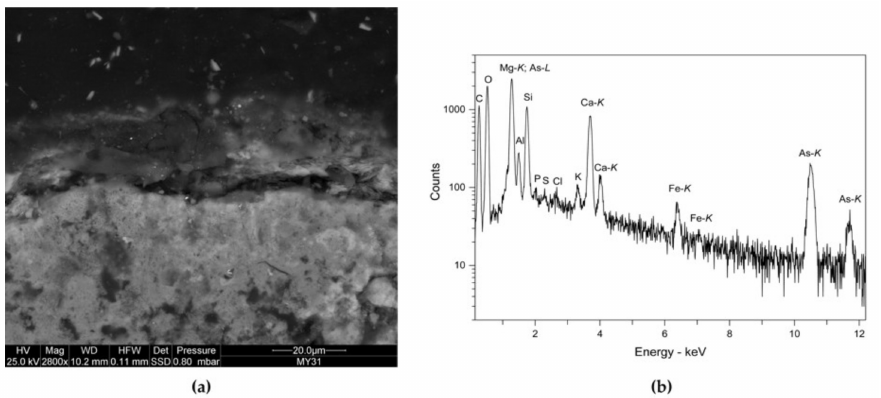
Figure 10. Sample MY31: ( a ) BSE-SEM micrographs; ( b ) EDS spectrum of the primer